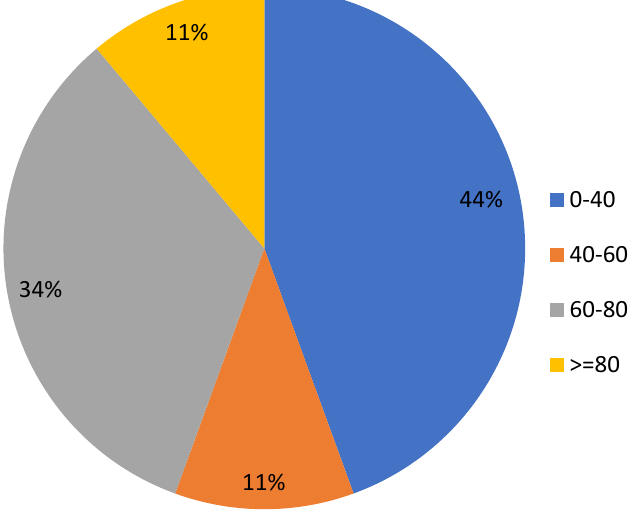
Figure 3. EP value of tested samples (%). Table 3. MC, TM and EP of tested insecticides (%).